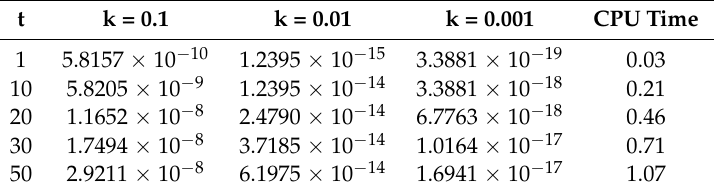
Table 2. Numerical results in form of L ∞ error norm using the EEM for Test Problem